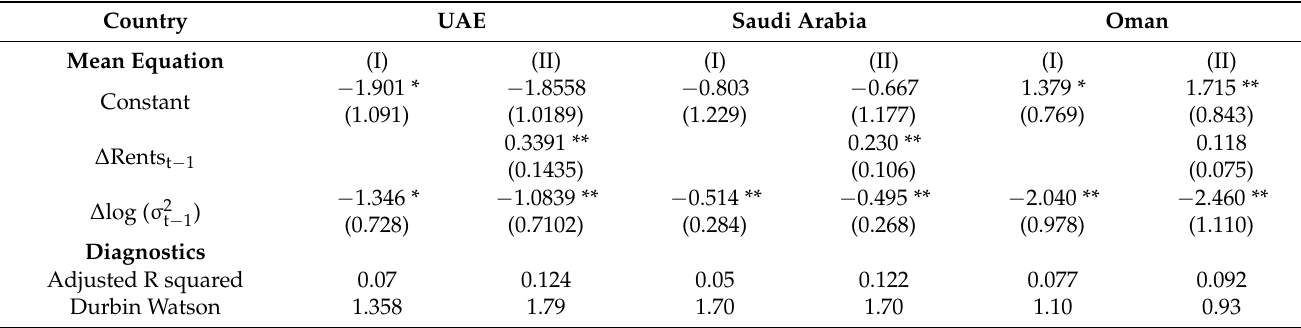
Table 4. OLS Regression Estimates: Dependent variable: GDP Growth rate per